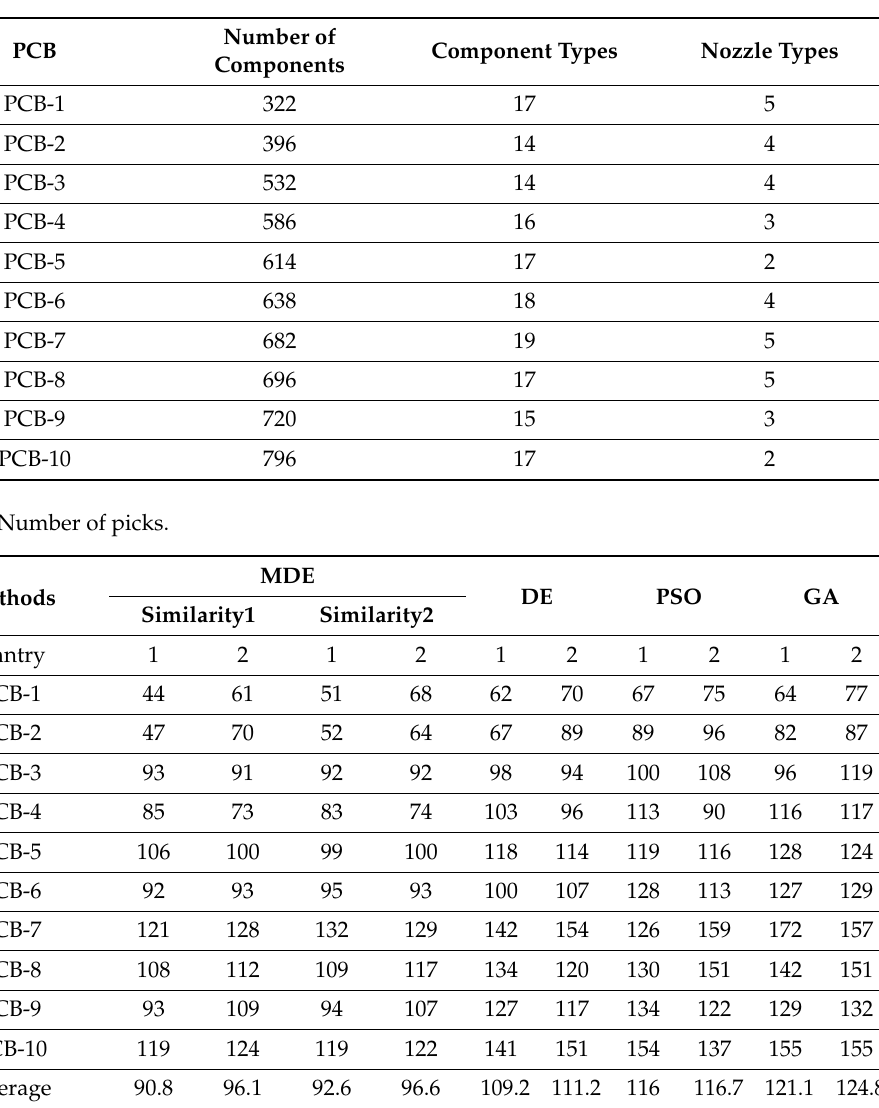
Table 3. PCB information.